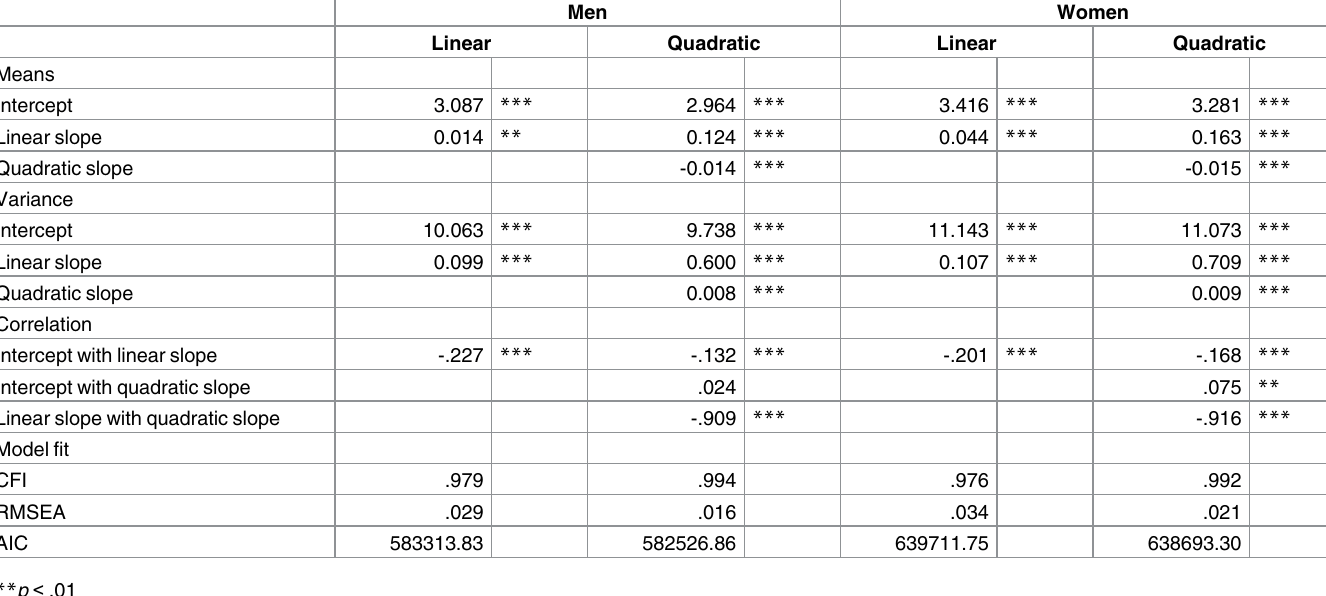
Table 3. Estimated values of the linear growth model (linear) and the quadratic growth model (quadratic) for depressive state with latent growth modeling by